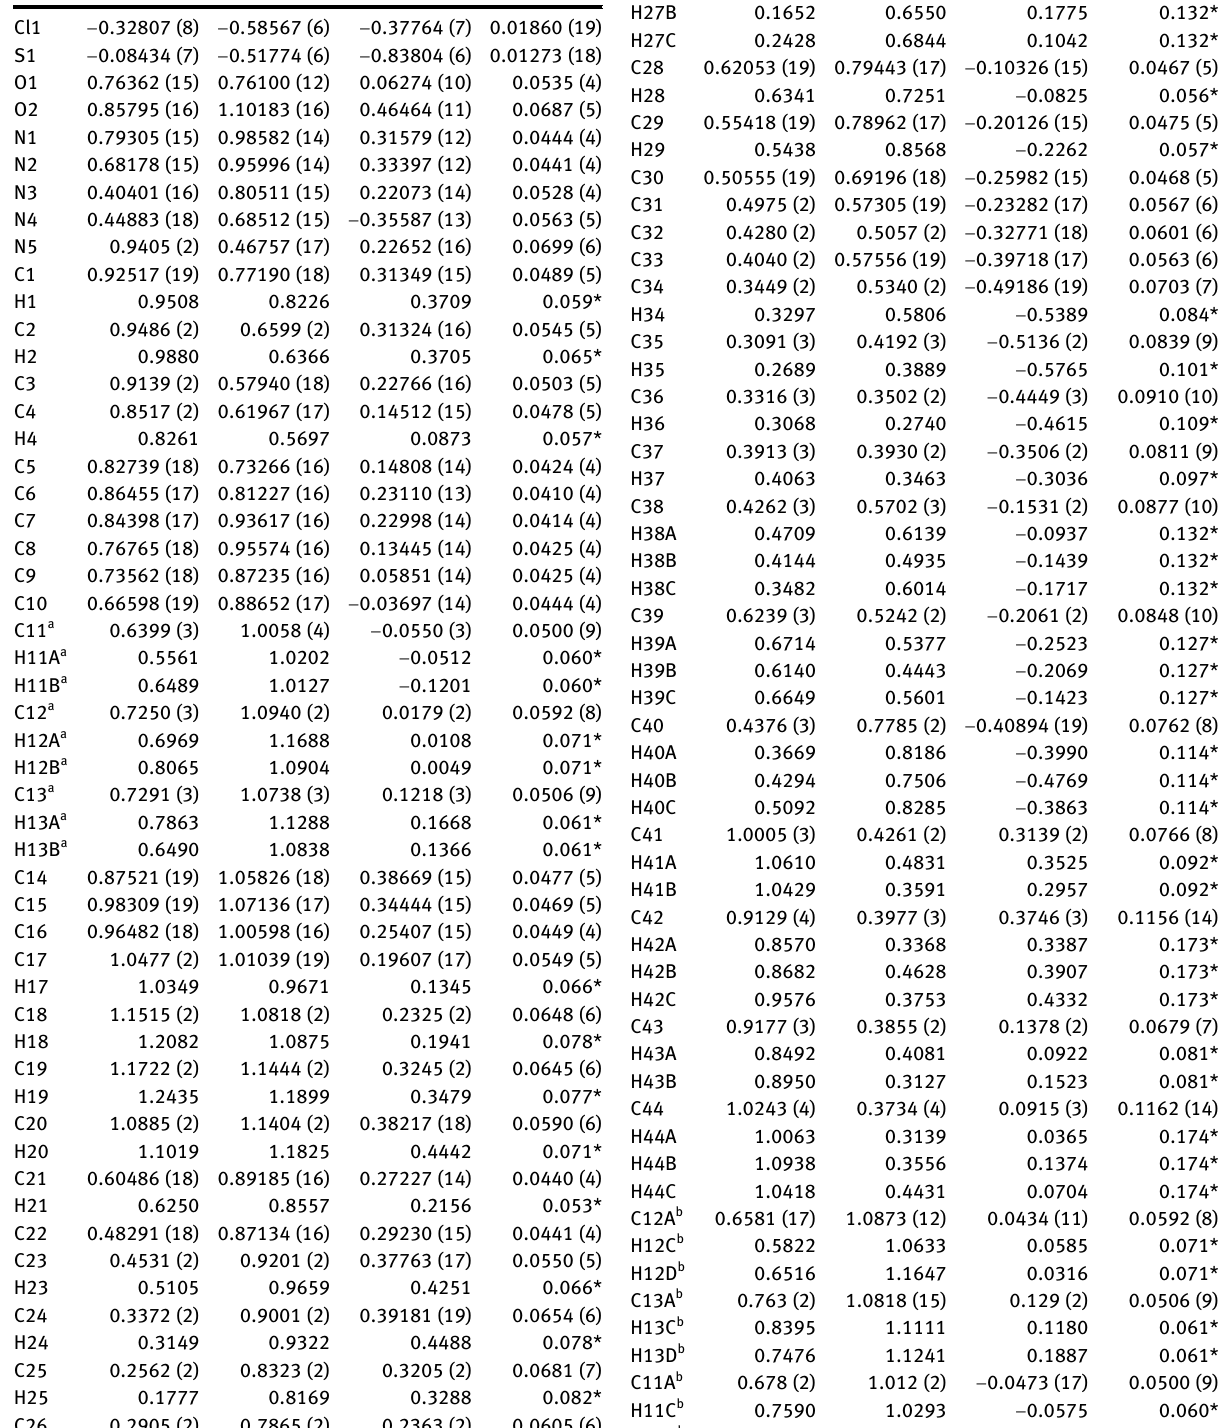
Table  : Fractional atomic coordinates and isotropic or equivalent isotropic displacement parameters (Å 